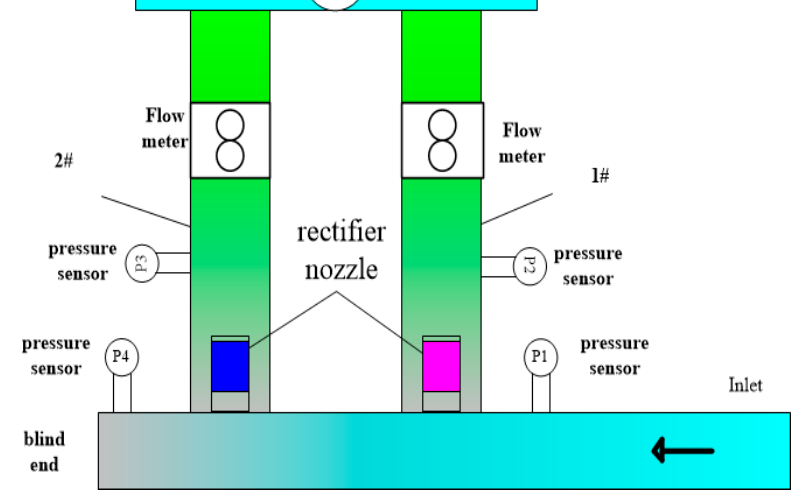
Figure 2. Sketch map of test section.